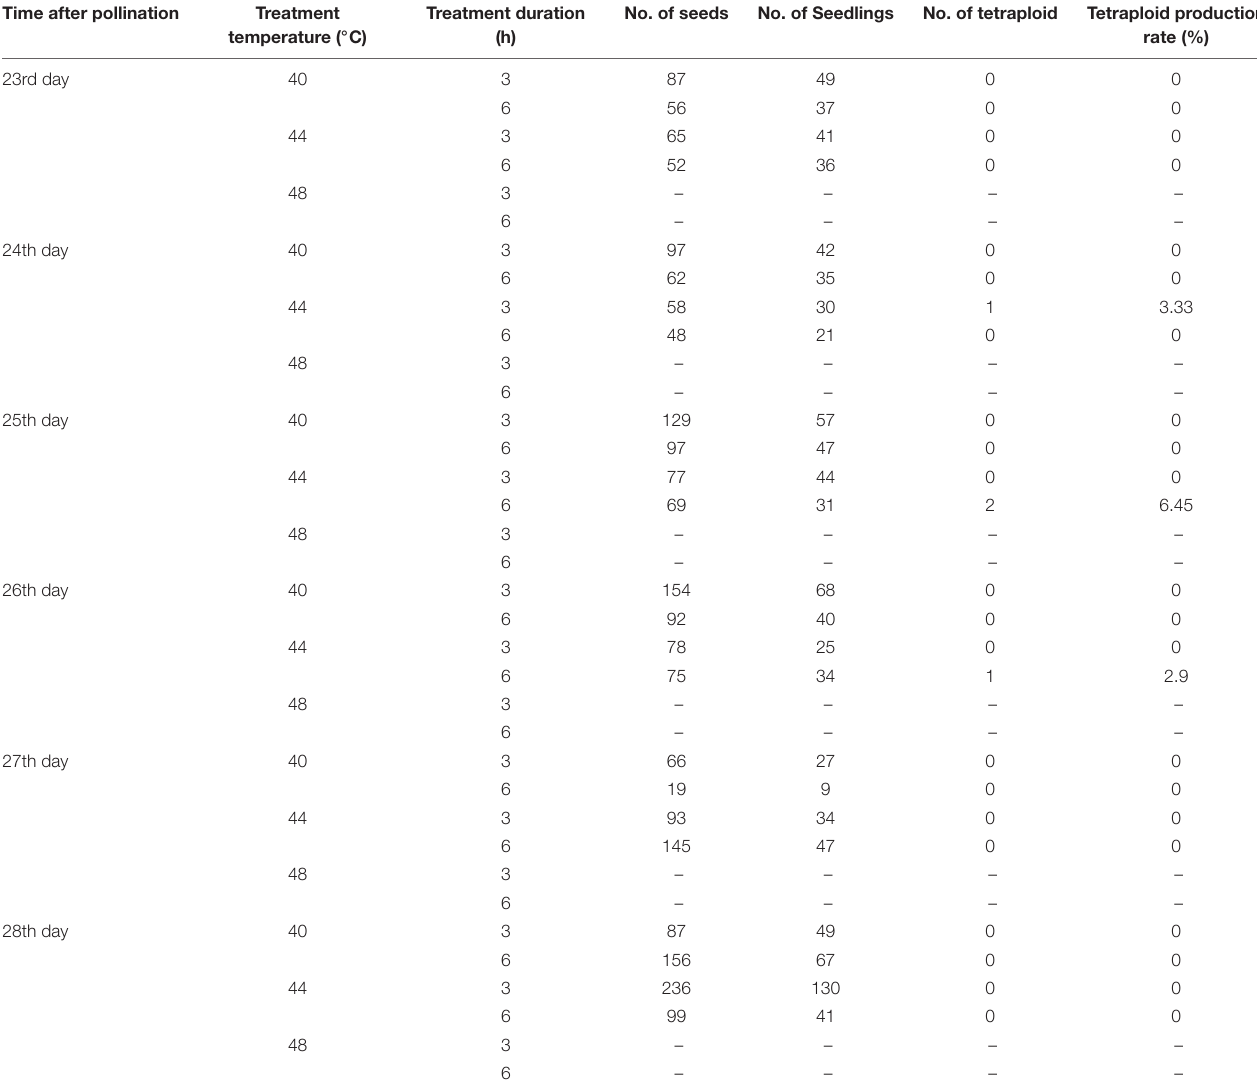
TABLE 2 | Eucalyptus urophylla tetraploid production via zygote chromosome doubling by high temperature. Time after pollination Treatment Treatment duration No. of seeds No. of Seedlings No. of temperature ( ◦ C) (h)